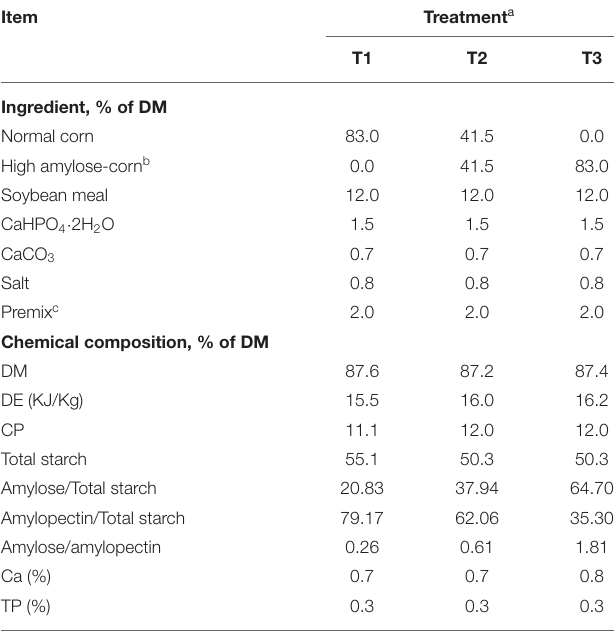
TABLE 1 | Ingredients and chemical composition (% of DM) of the treatment diets.